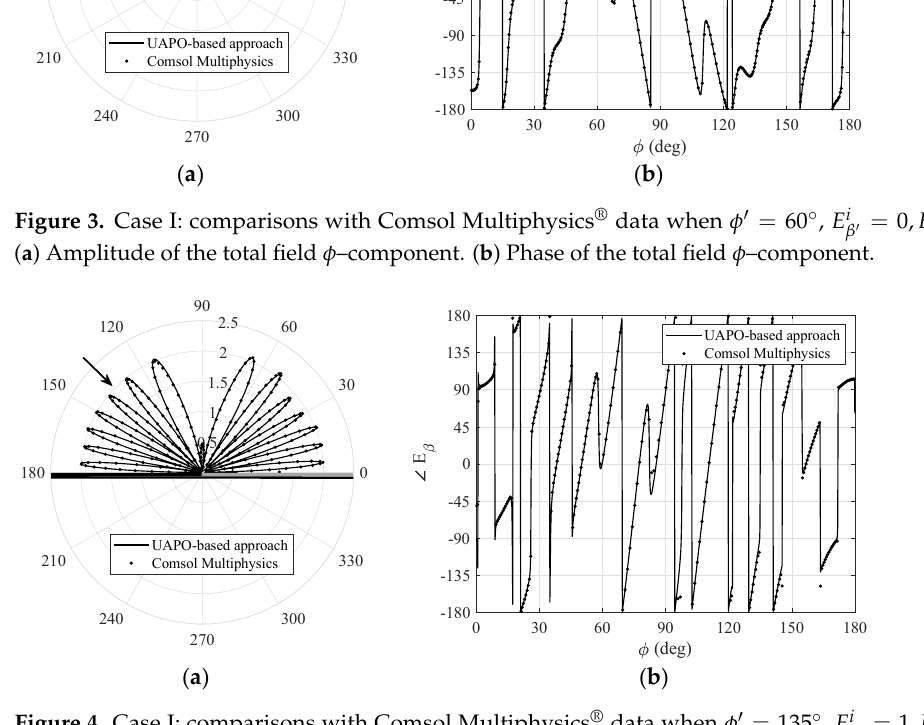
i = 1, E i = 0 . ( a ) φ (cid:48) β (cid:48) b ' f '